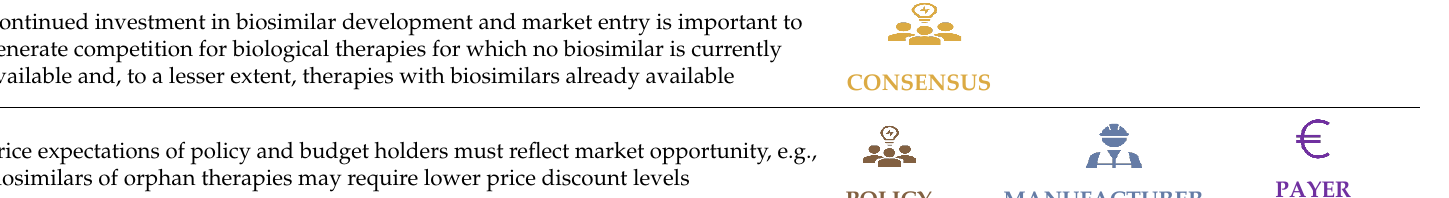
Table 1. Consensus on components of a sustainable biosimilar